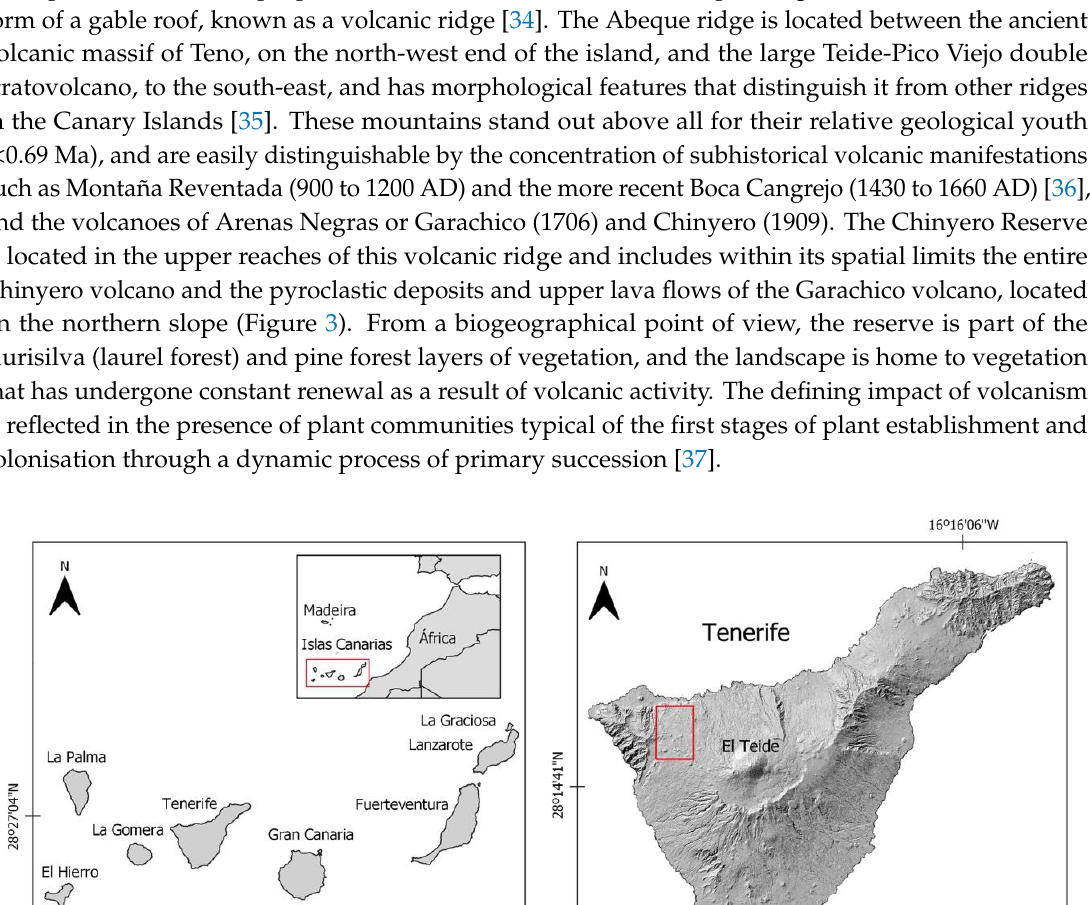
Figure 2. Structure and justification for the proposed route. Source: self-elaboration.